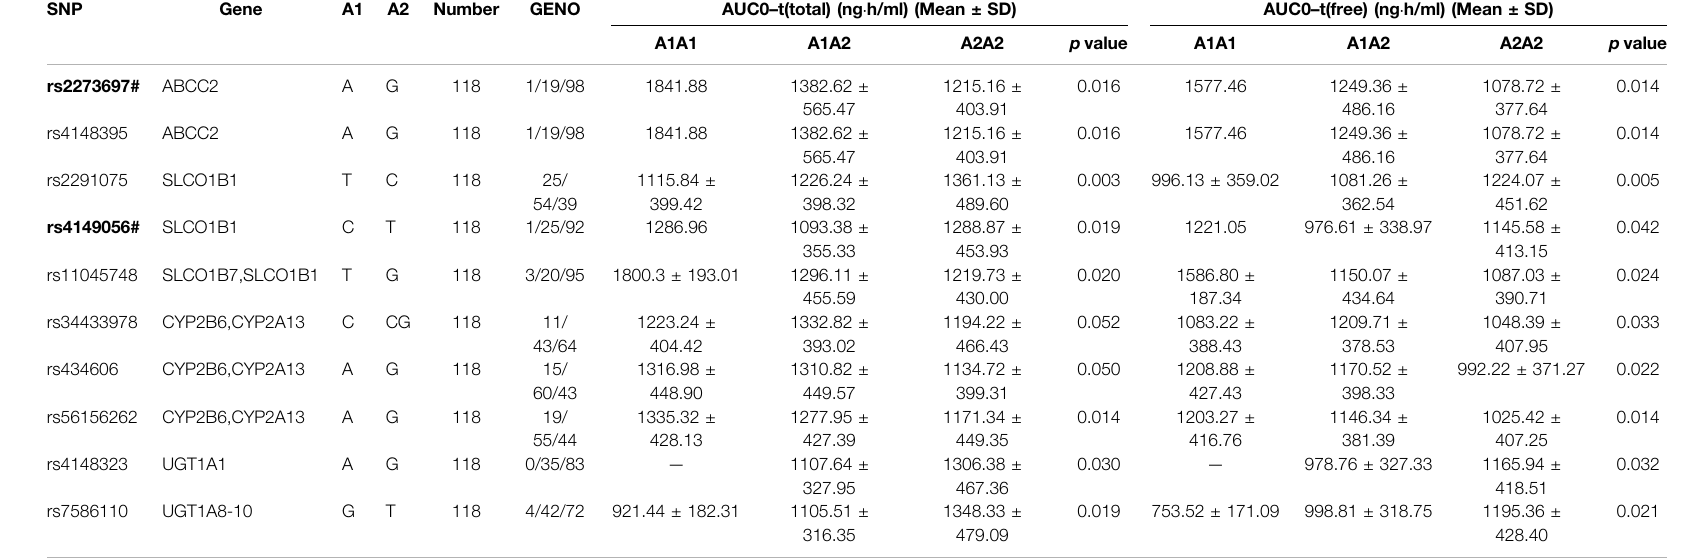
TABLE 3 | Positive effects of candidate genes on AUC 0 – t of total and free